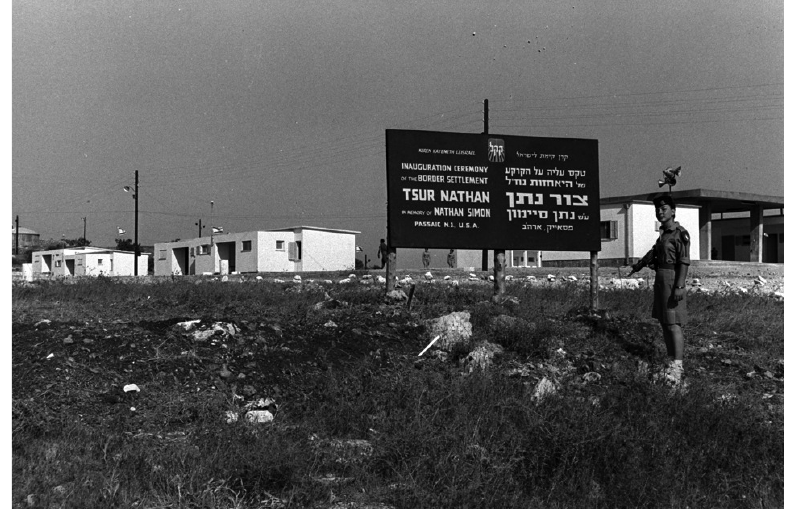
Figure 5. Nahal soldiers in Tzur‐Nathan. Source: Milner (1966). the community while emphasising the public core, which was placed in the settlement’s highest point (Figure 6).